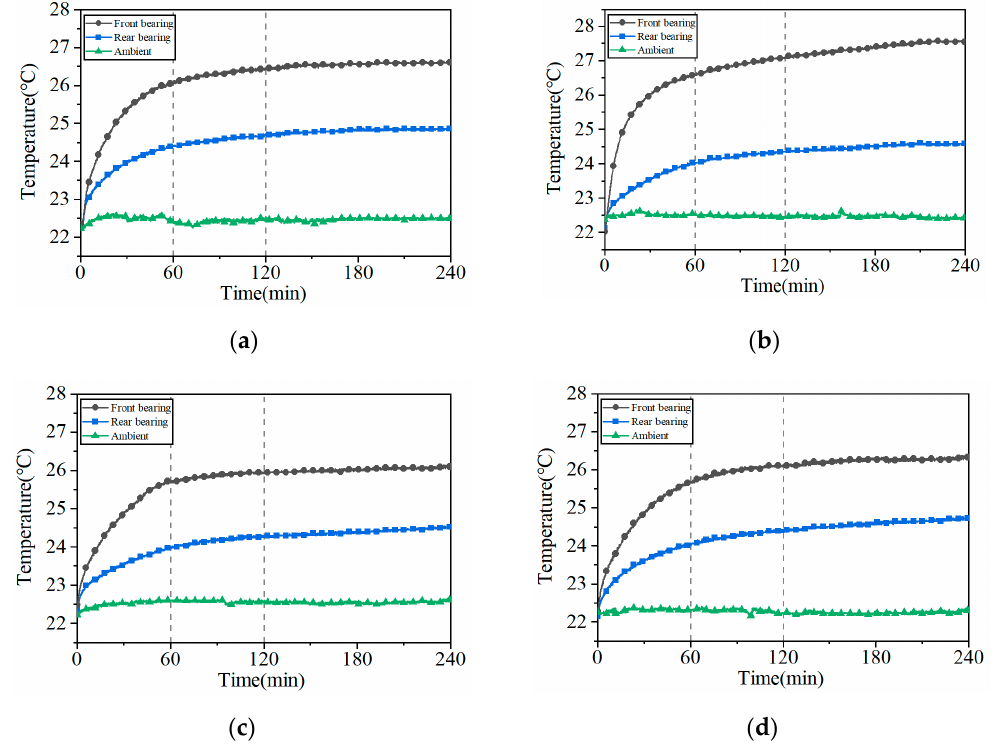
Figure 15. Experimental results of node temperature of the ball screw feed system under different working conditions: ( a ) working condition 1; ( b ) working condition 2; ( c ) working condition 3; and ( d ) working condition 4.